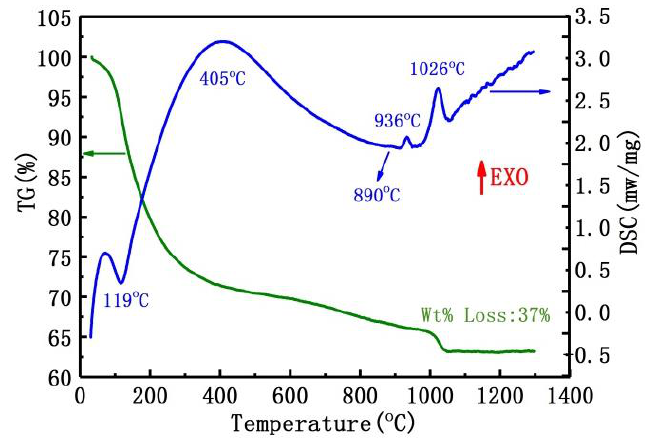
Figure 1. Thermogravimetric-differential scanning calorimeter (TG-DSC) curves of the as synthesized Yb:LuYAG precursors.